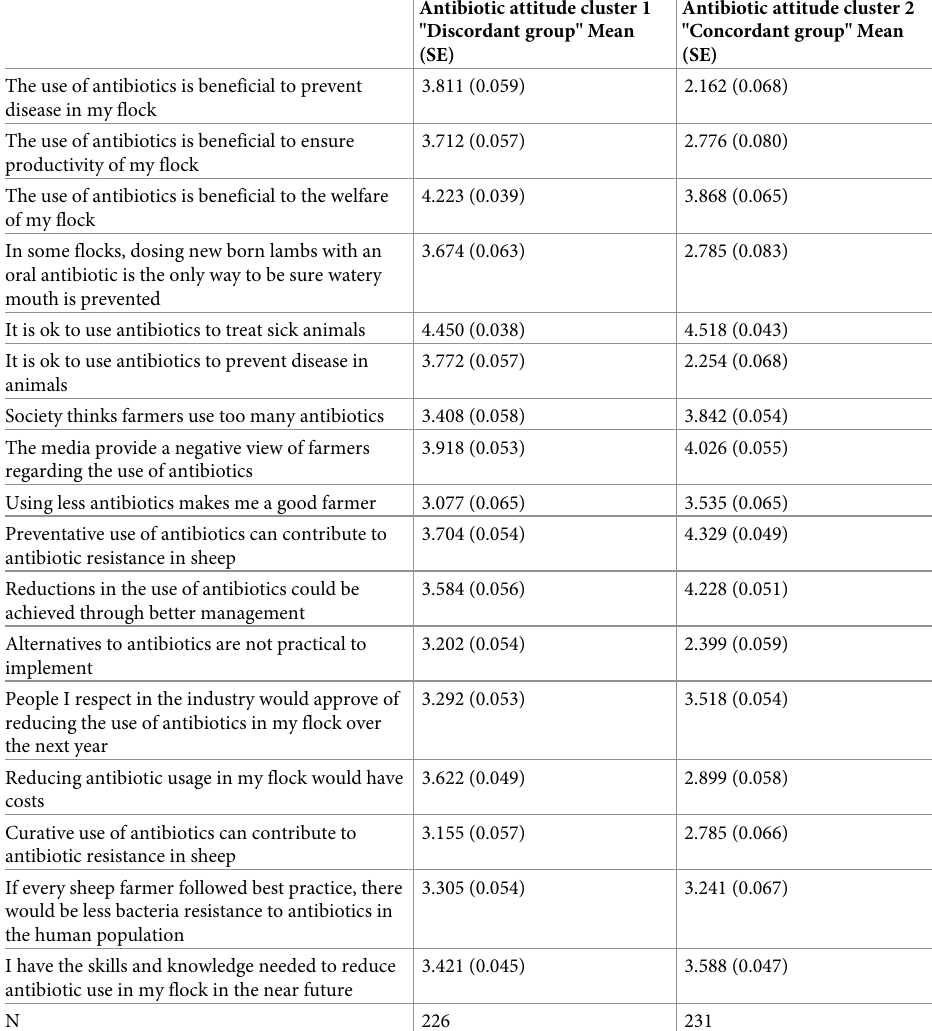
Table 2. Mean ratings of antibiotic statements for two clusters of farmers (1 = strongly disagree, 5 = strongly agree).